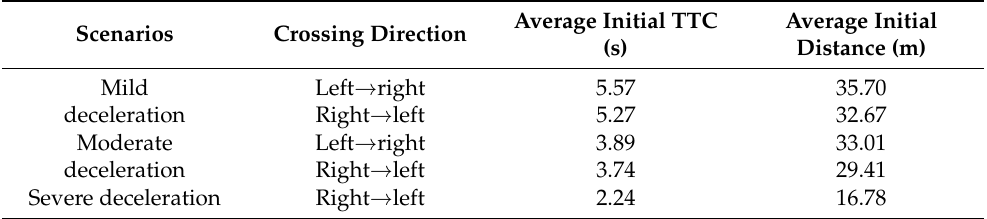
Table 2. The impact of different crossing directions on vehicle